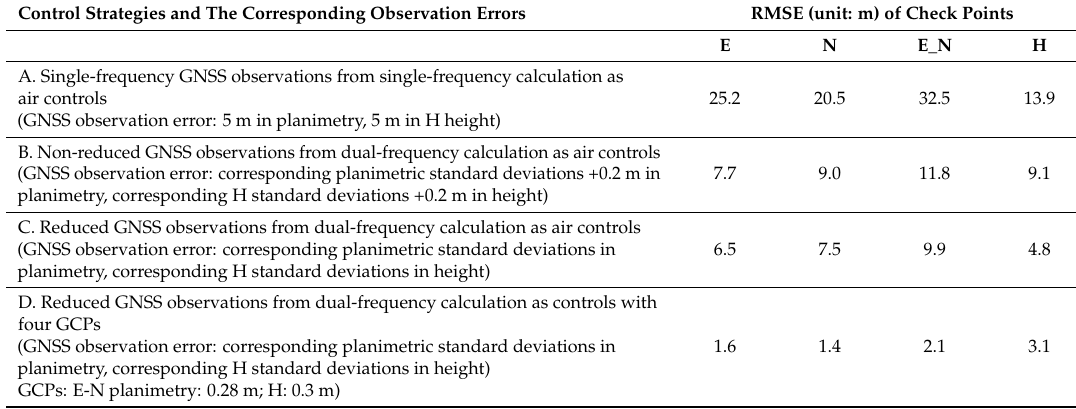
Table 4. The accuracy of GNSS-supported self-calibration aerial triangulation (AT) based on different control strategies.